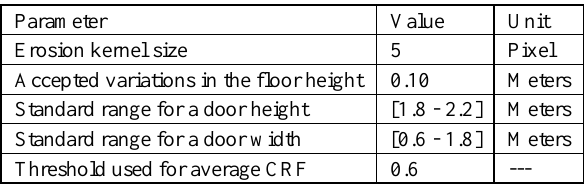
Table 4. Confusion matrices showing accuracy in detecting